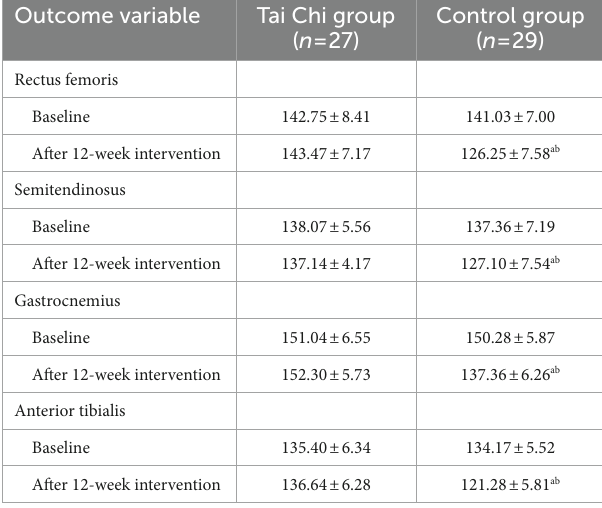
TABLE 2 Comparison of reaction time at baseline and 12-week follow-up among the two groups (mean ± standard